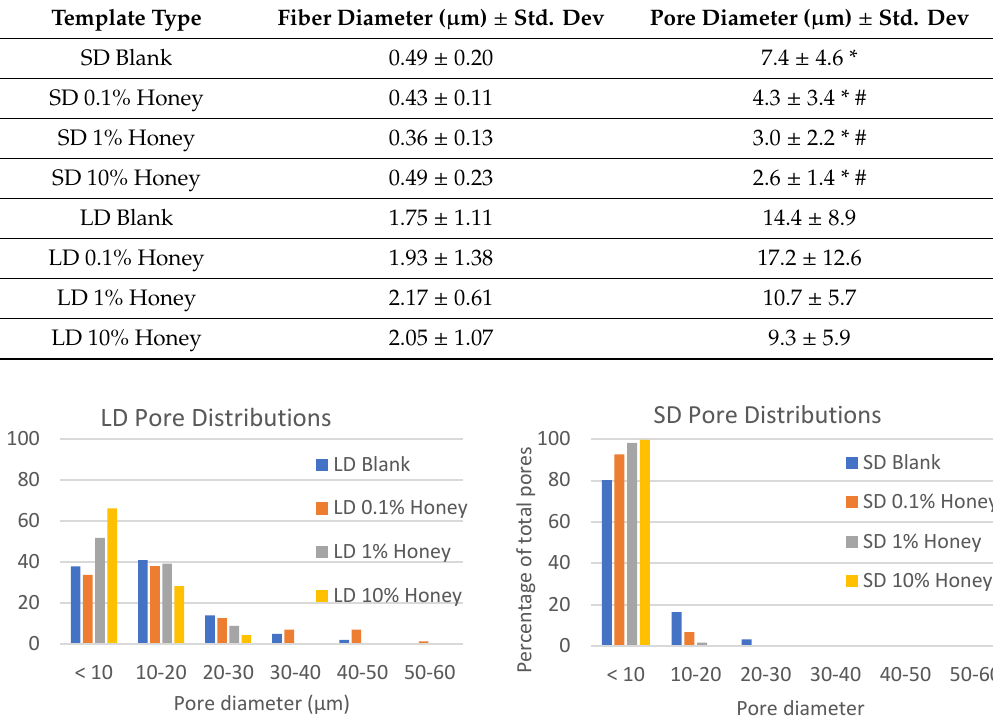
Figure 3. Honey release is higher for SD templates than LD templates. Percent honey v/v in PBS incubated with each template type for 21 days. * indicates a significant difference between the LD and SD templates of the corresponding honey concentration, and + indicates a significant difference from all other honey concentrations and non-honey blank of the corresponding fiber diameter (SD or LD). Note: the 1% honey LD samples are significantly different from the LD blank from day 3 onward, the 1% honey SD samples are significantly different from SD blank for days 14 and 21, and the 0.1% honey SD samples are significantly different from SD blank from day 3 onward. Due to clustering of these lines on the graphs, these differences were unable to be notated. Sample size = 4. Raw data is available in Supplementary Spreadsheet 2.